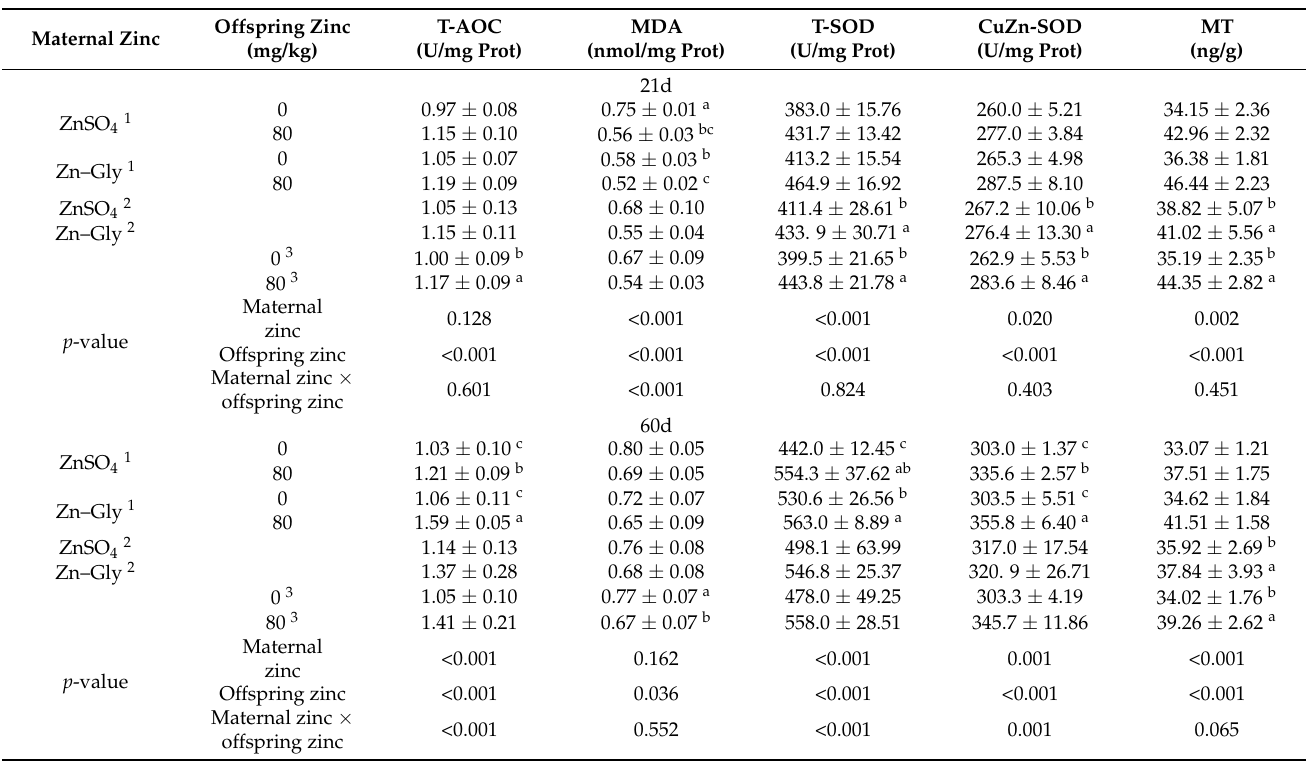
Table 6. Effects of maternal Zn in conjunction with their offspring dietary Zn supplementation on liver antioxidant indexes in offspring broilers (mean ±